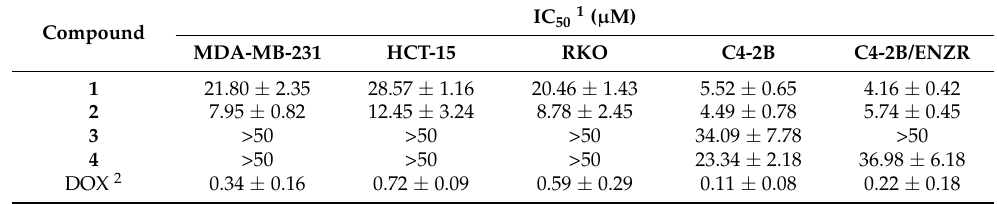
Table 2. IC 50 data of compounds 1 – 4 for the indicated cell